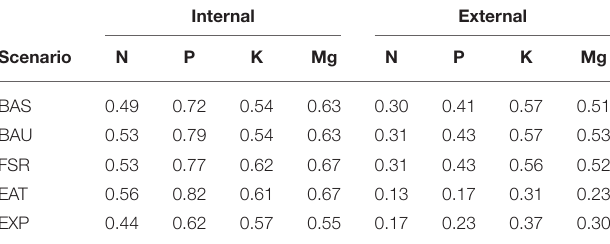
TABLE 4 | Nutrient self-reliance—current residual management practices. Internal External Scenario